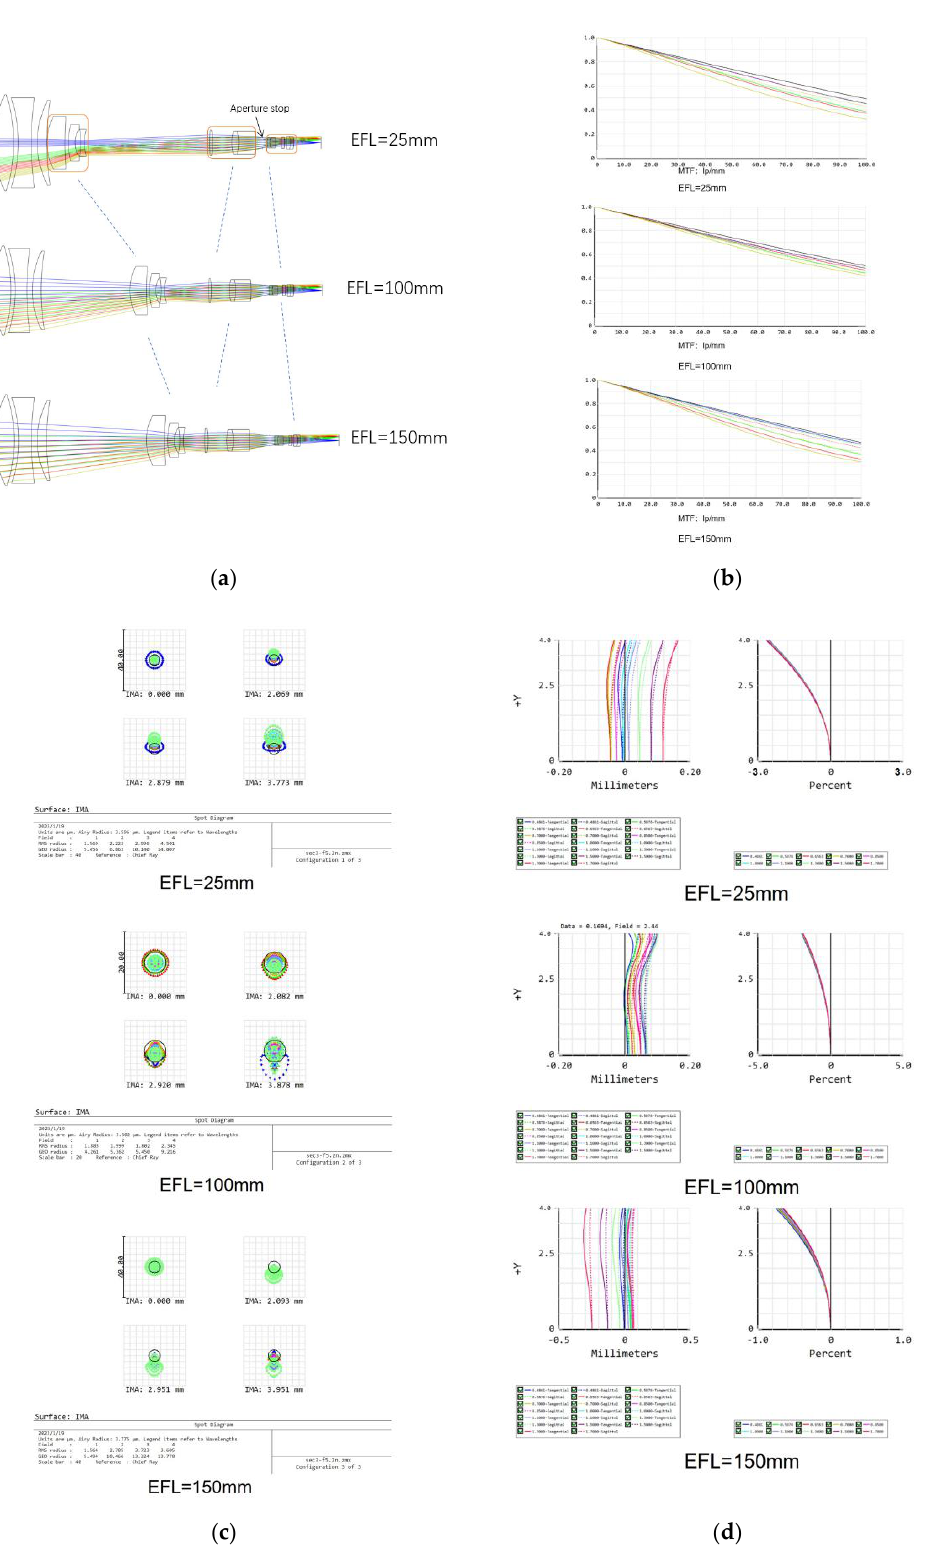
Figure 5. ( a ) Final layout of the zoom optical system; ( b ) MTF curves of the zoom optical system [f = 25 mm, f = 100 mm, f = 150 mm]; ( c ) Spot diagrams; ( d ) Distortion diagrams.